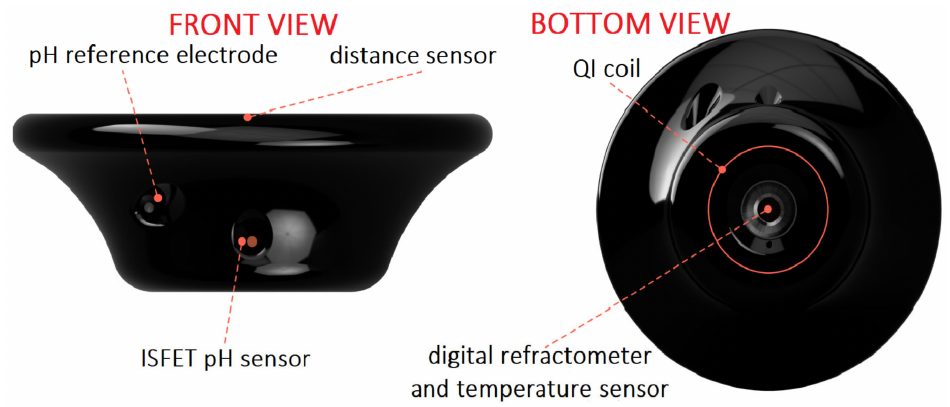
Figure 2. Probe for collecting information on selected cutting fluid